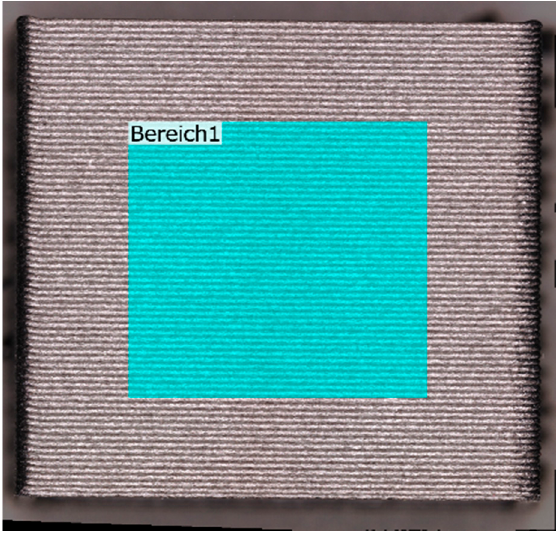
Figure 3. Example of surface roughness scanning area on experiment N14 .